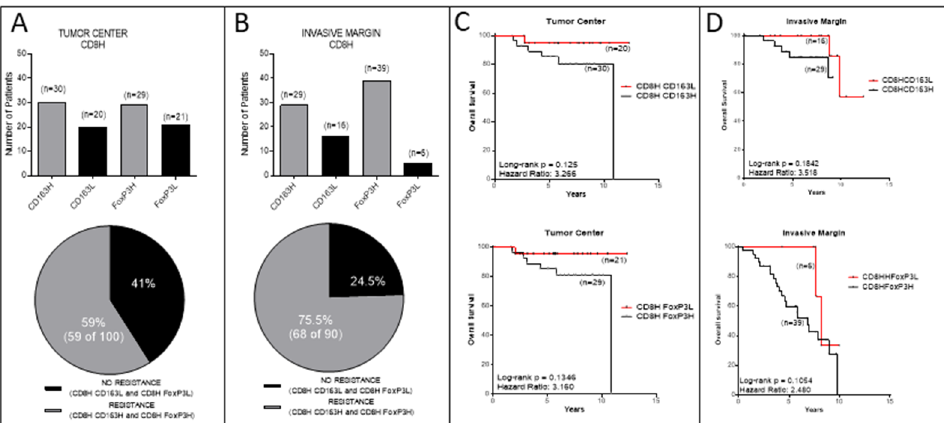
Figure 4. Association between CD8+ and CD163+ or FoxP3+ cell densities separately in the TC and in the IM and correlation with overall survival (OS). ( A ) Number of patients with high CD8+ cell densities in the TC (CD8H) and either high or low densities of CD163+ (CD163H or CD163L, respectively) or high or low densities of FoxP3+ (FoxP3H or FoxP3L, respectively) cells. ( B ) Number of patients with high CD8+ densities in the IM (CD8H) and either high or low densities of CD163+ (CD163H or CD163L, respectively) or high or low densities of FoxP3+ (FoxP3H or FoxP3L, respectively) cells. ( C ) Kaplan-Meier survival curves for patients with high densities of CD8+ cells and high or low densities of CD163+ cells (upper panel) and for patients with high densities of CD8+ cells and high or low densities of FoxP3+ cells (lower panel) in TC. ( D ) Kaplan-Meier survival curves for patients with high densities of CD8+ cells and high or low densities of CD163+ cells (upper panel) and for patients with high densities of CD8+ cells and high or low densities of FoxP3+ cells (lower panel) in IM.